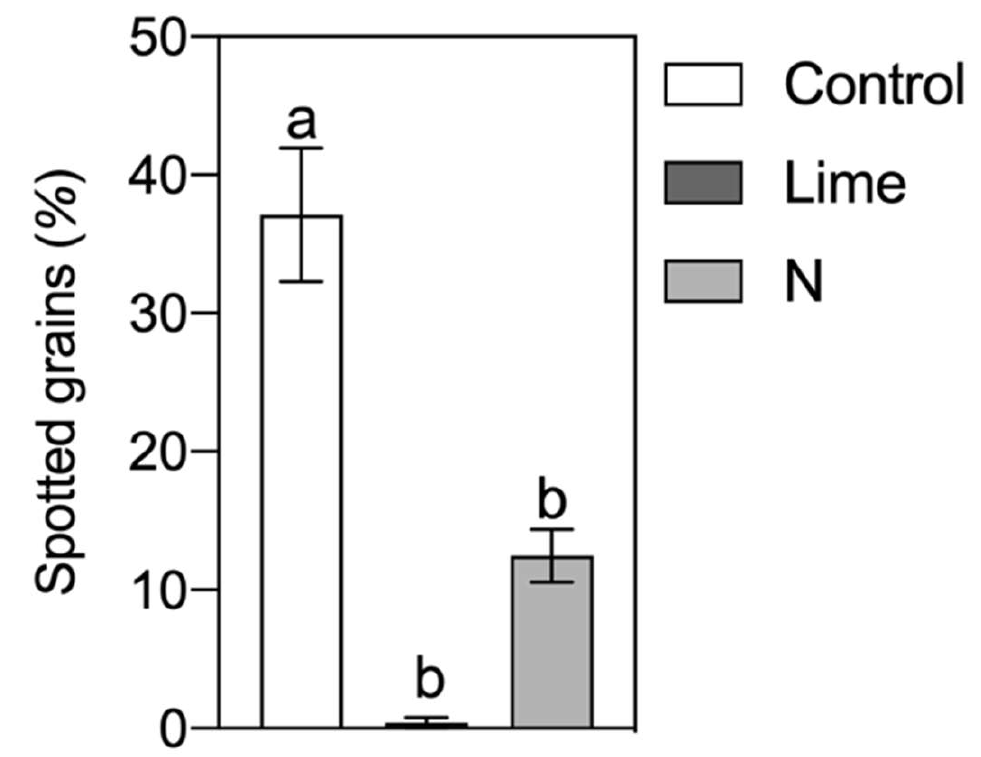
Figure 4. Percentage of spotted grains evaluated in lentils grown in pots depending upon the treatments with no nutrient addition, and lime and N applications. The percentage was calculated in relation to the total number of grains obtained in the respective treatment. Small letters indicate significant differences among treatments after Tukey’s test ( p < 0.05).